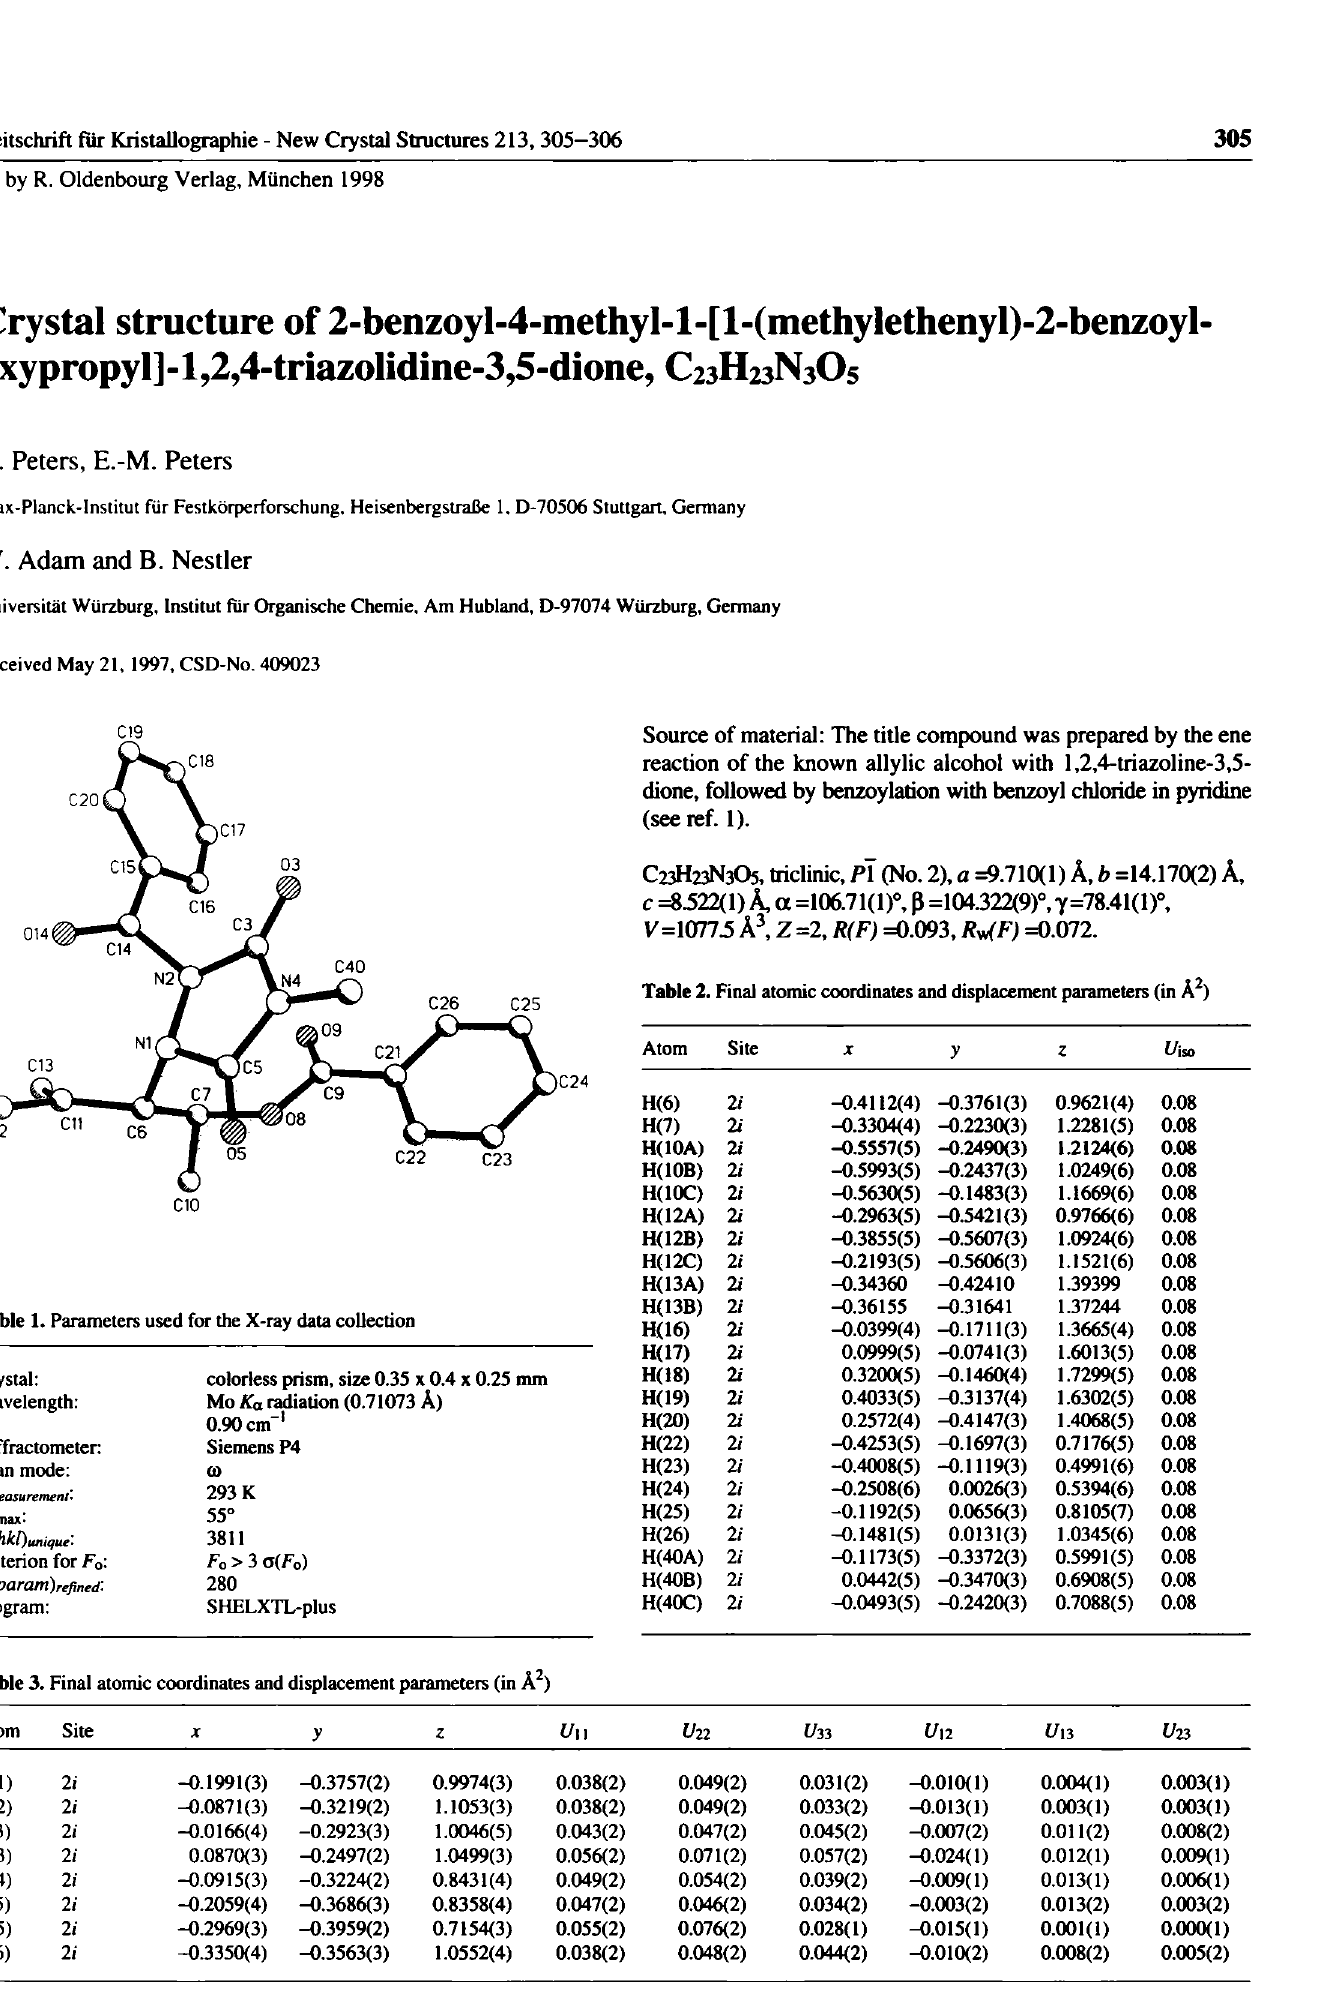
Table 1. Parameters used for the X-ray data collection Crystal: